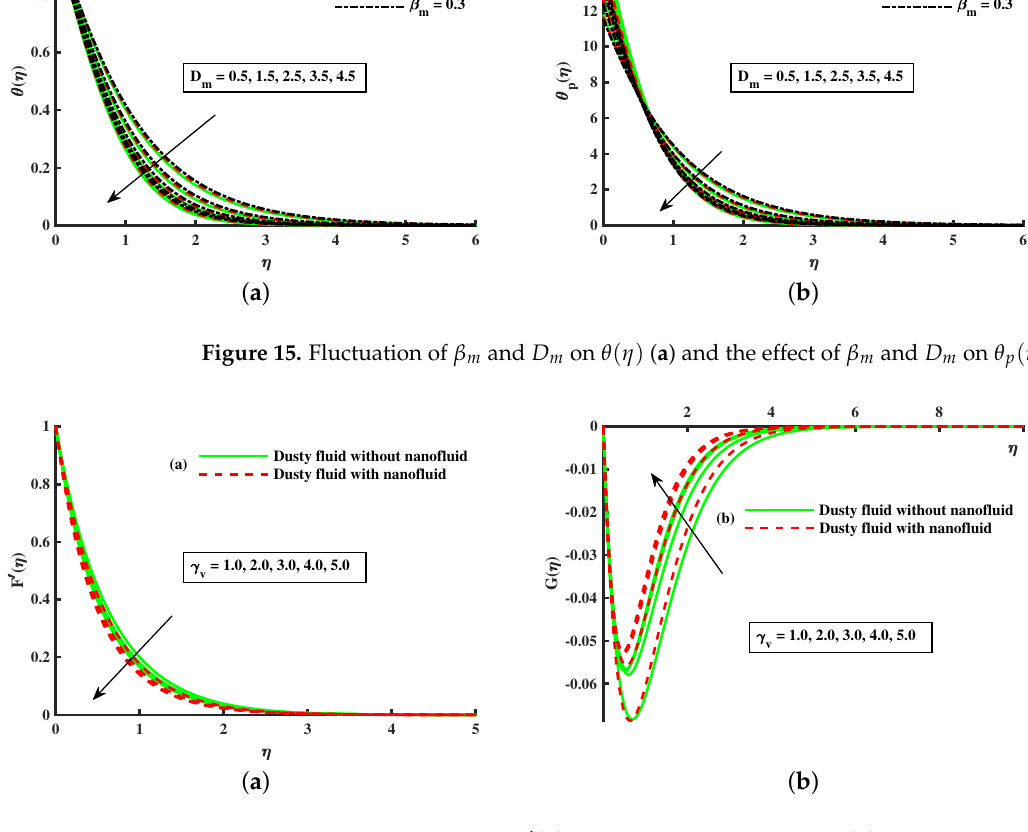
Figure 16. Fluctuation of γ v on F (cid:48) ( η ) ( a ) and the effect of γ v on G ( η ) ( b ).